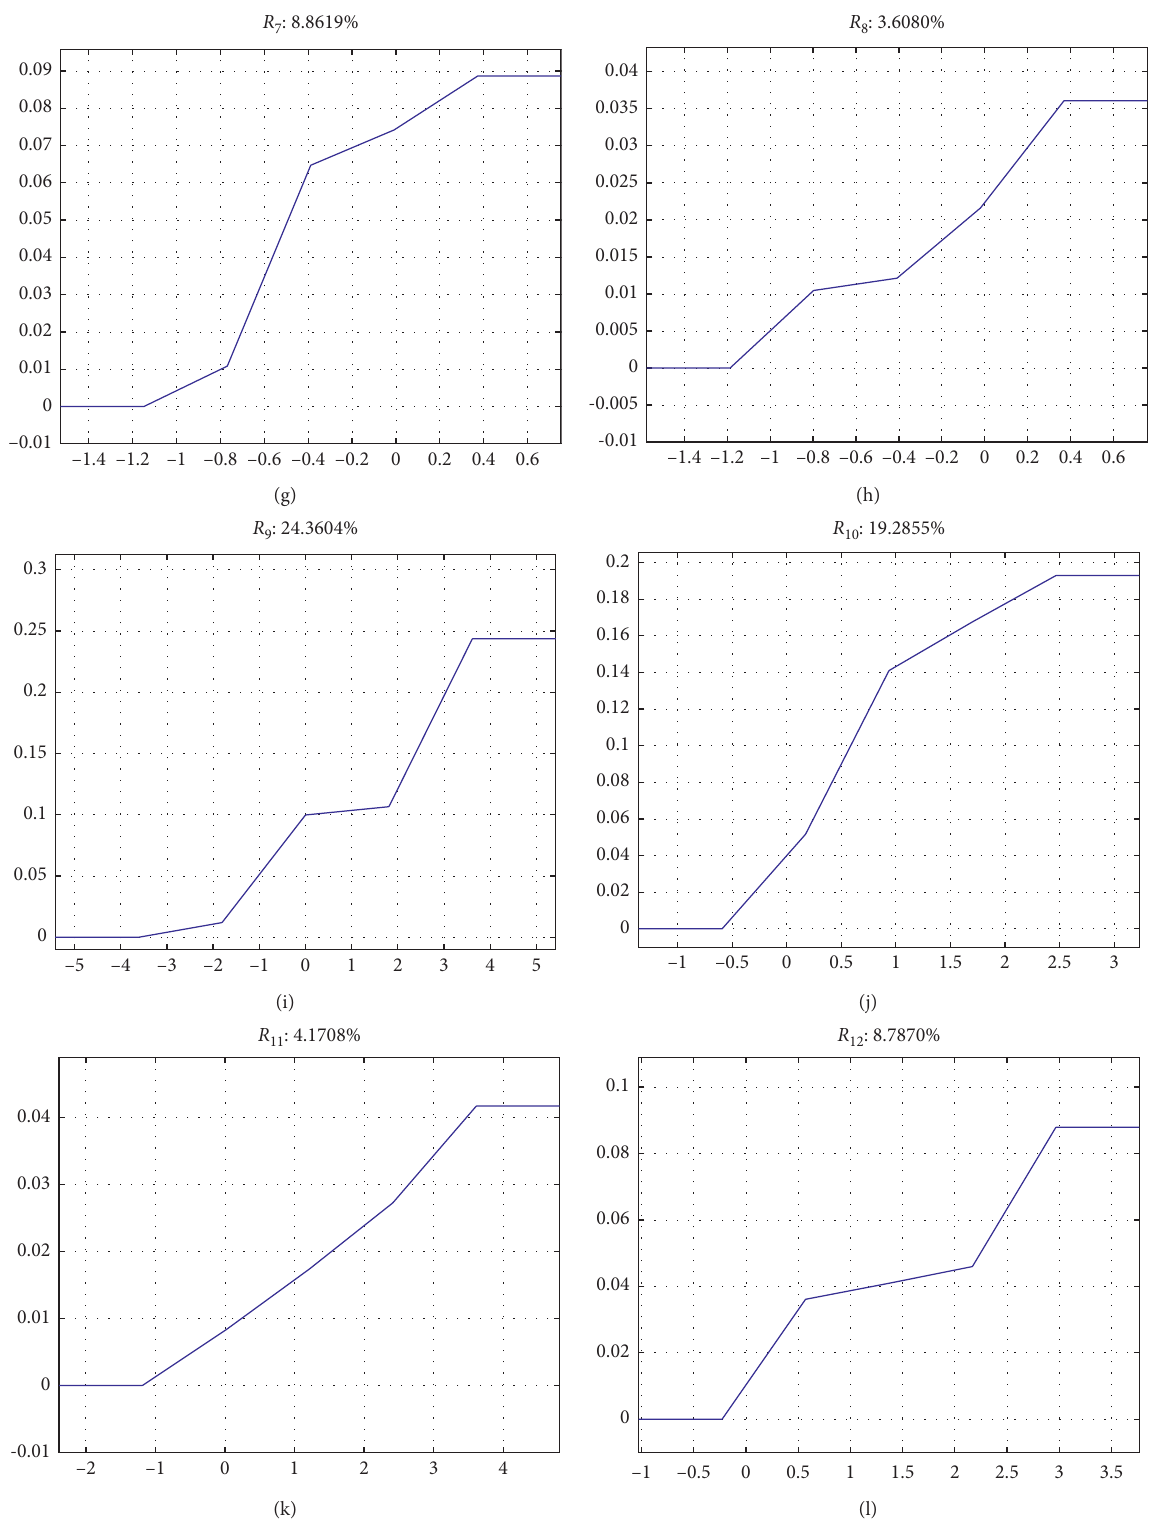
Figure 3: Marginal utility of each financial ratio using single UTADIS (training